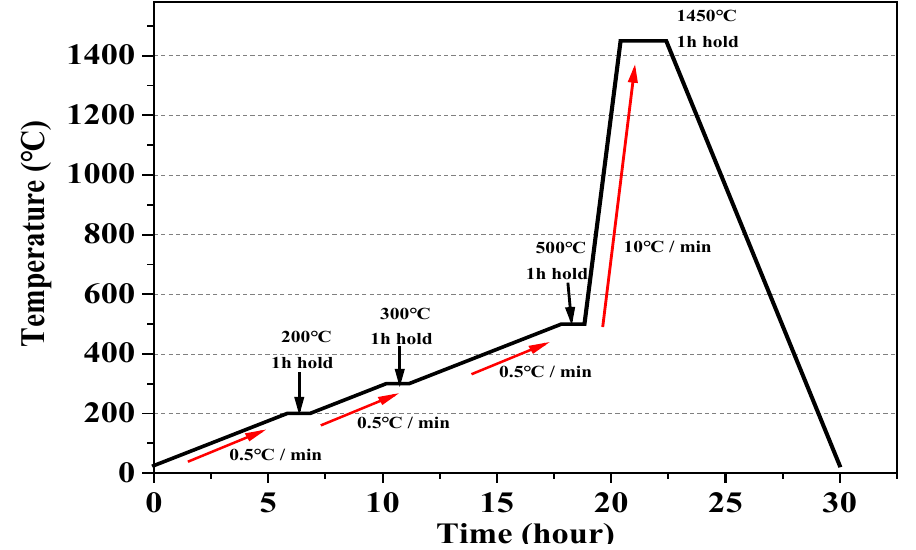
Figure 3. Sintering process of zirconia specimens (The red arrow indicates the heating rate.).